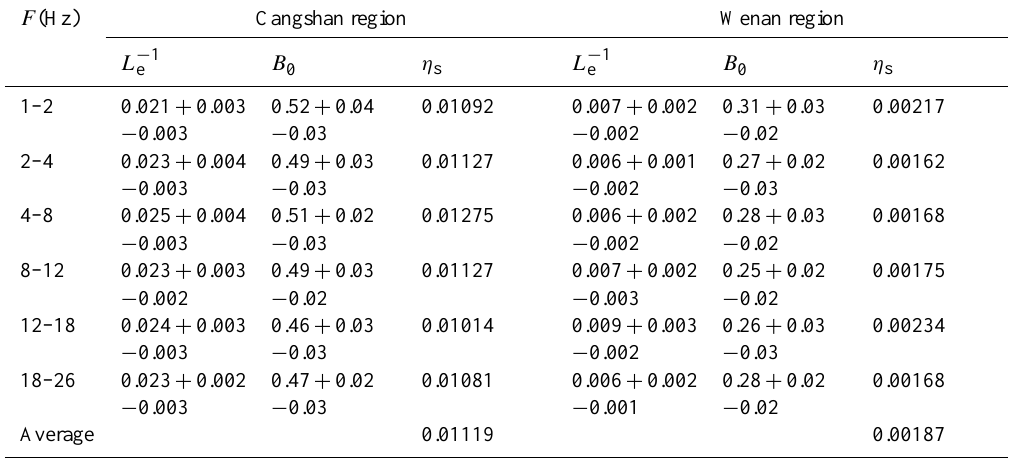
Table 2. Calculated results of seismic albedo B 0 , inverse of extinction length L − 1 e and scattering coefficients η s in the Cangshan and Wenan